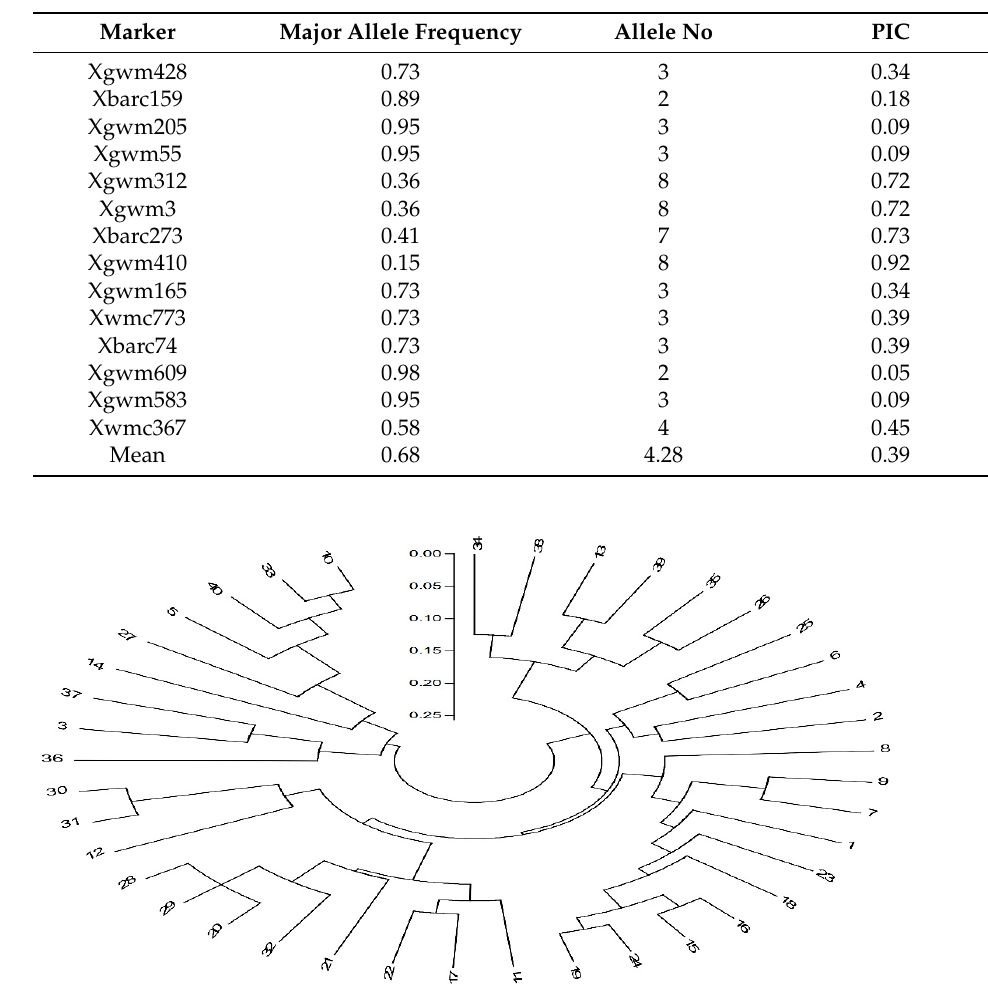
Table 4. Major allele frequency, allele number, gene diversity, and polymorphism information content of the 40 Ae. tauschii populations collected from China based on the 14 SSRs.